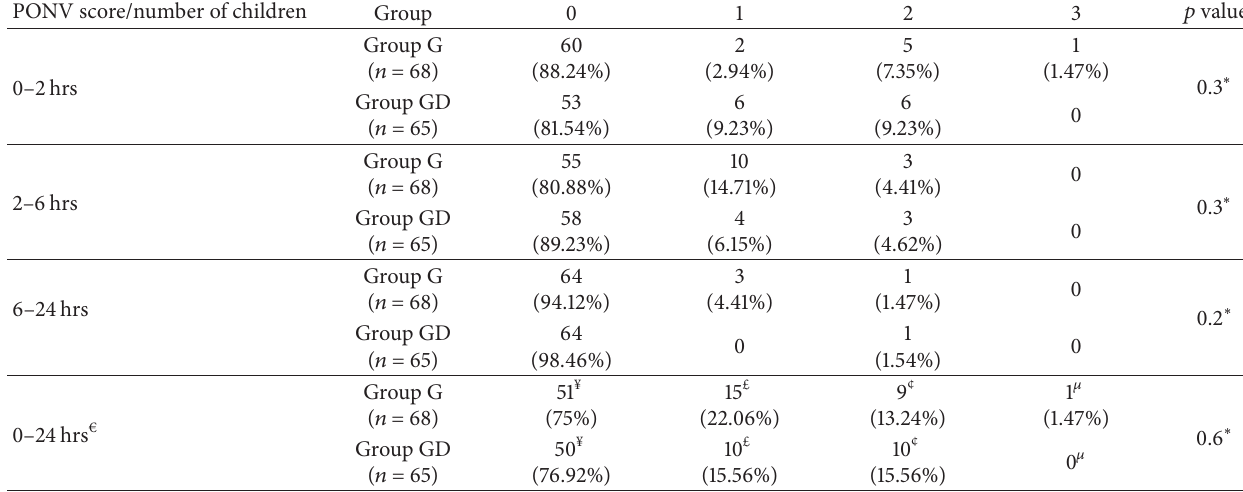
Table 3: Incidence and severity of postoperative nausea vomiting (PONV) in different time interval (0–24 hours). PONV score/number of children